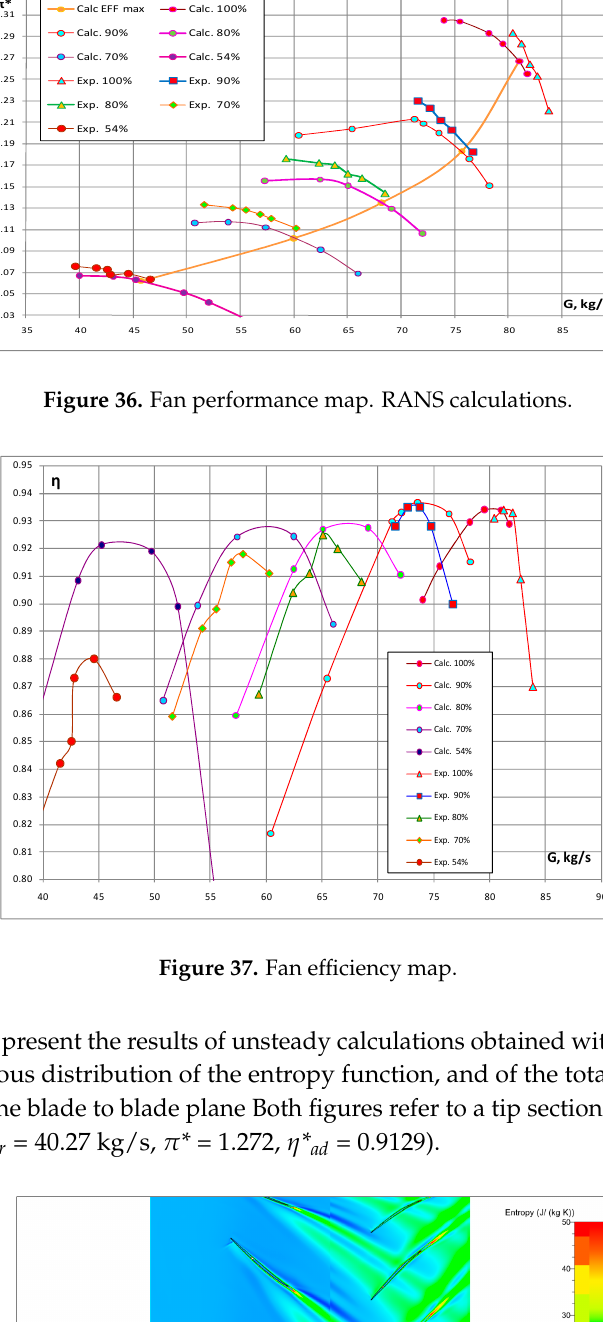
Figure 38. Unsteady Reynolds Averaged Navier–Stokes (URANS) calculations: instantaneous entropy field. Section 0.95 h. Operating point at (cid:1866)(cid:3364) = 100%.